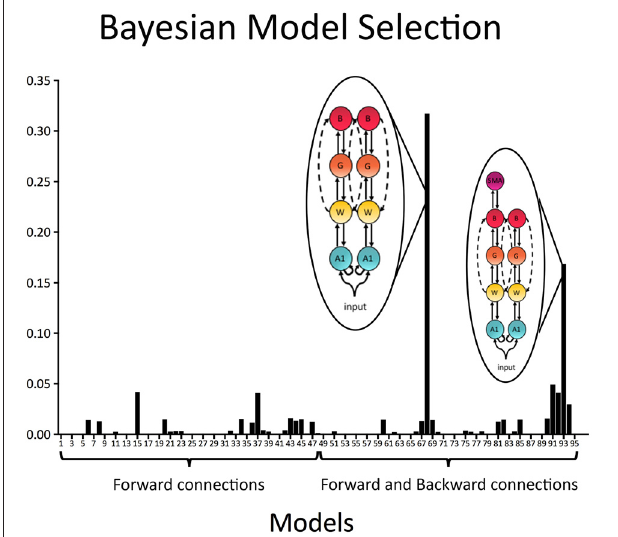
FIGURE 4 | Model exceedance probability for attenuation of predictable speech. Bayesian model selection (random effects) over the whole model space indicated speech sound prediction was best explained by a model with recurrent (i.e., forward and backward) connections between bilateral primary auditory cortex (A1), Wernicke’s area (W), Geschwind’s territory (G) and Broca’s area (B), as well as direct bilateral connections between W and B. This model was followed by a model, which was in all equal to the winning model except that it included a connection from B to SMA in the left